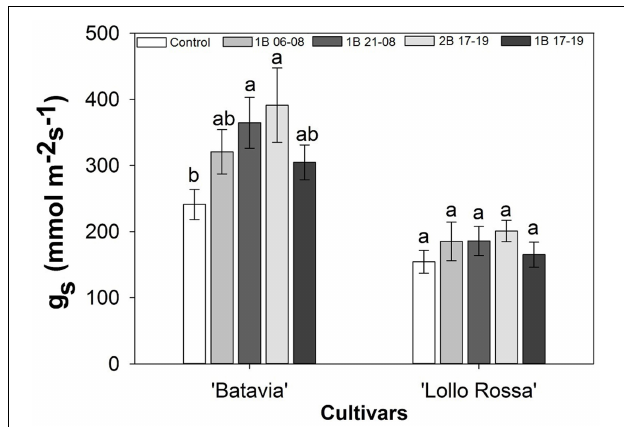
FIGURE 3 | Stomatal conductance (g s ) of Lactuca sativa “Batavia” and “Lollo Rossa” grown under the five different LED treatments with the same abbreviations as in Figure 2. Data are mean values ( n = 20, five replications, four different leaves from different plants per treatment and cultivar) ± SE. Assignment of the same letters indicates values that are not significantly different at P -values < 0.05 within treatments.